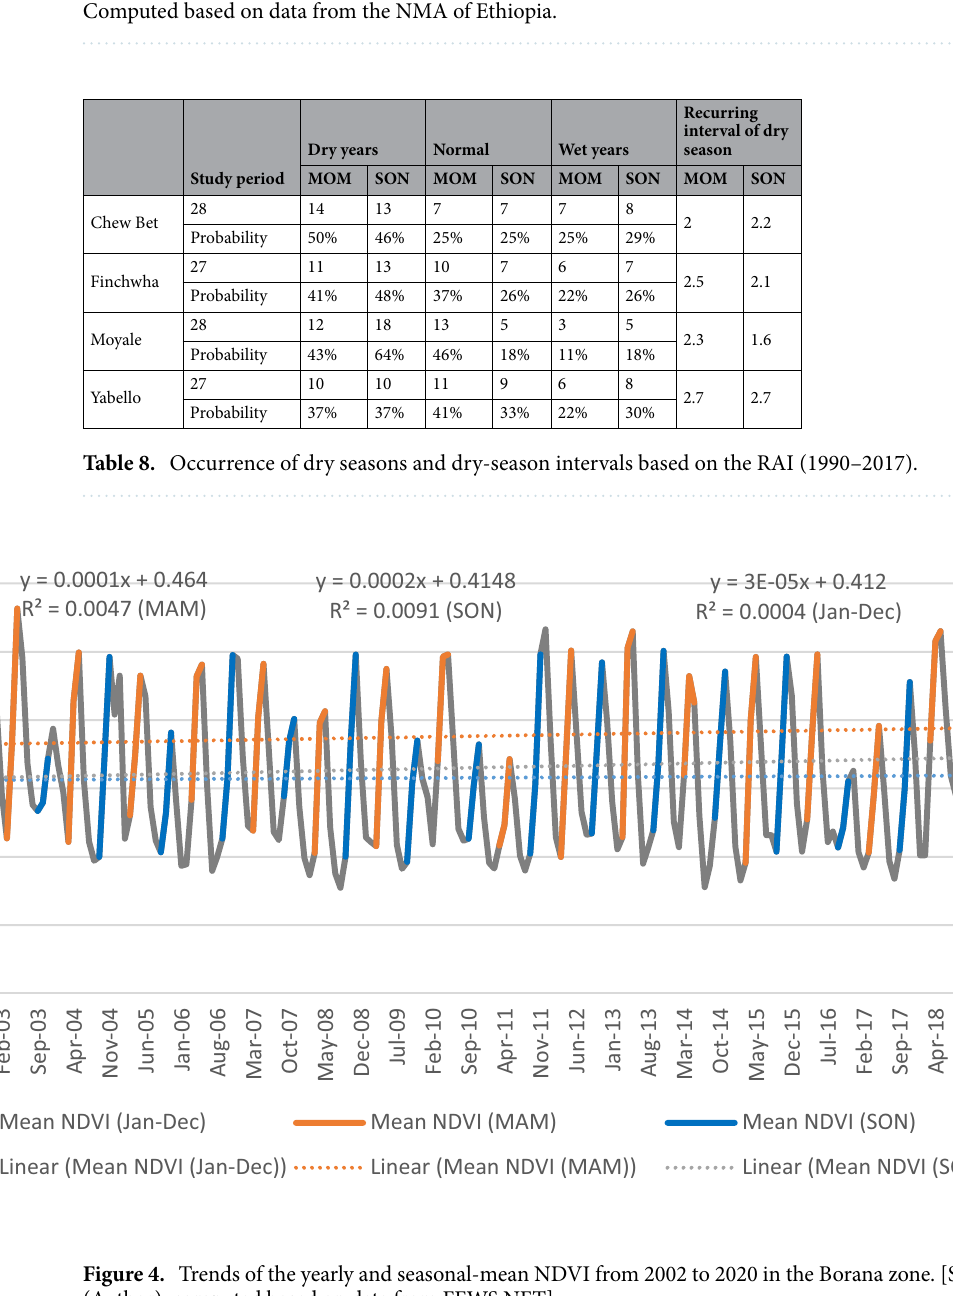
Figure 4. Trends of the yearly and seasonal-mean NDVI from 2002 to 2020 in the Borana zone. [Source (Author): computed based on data from FEWS